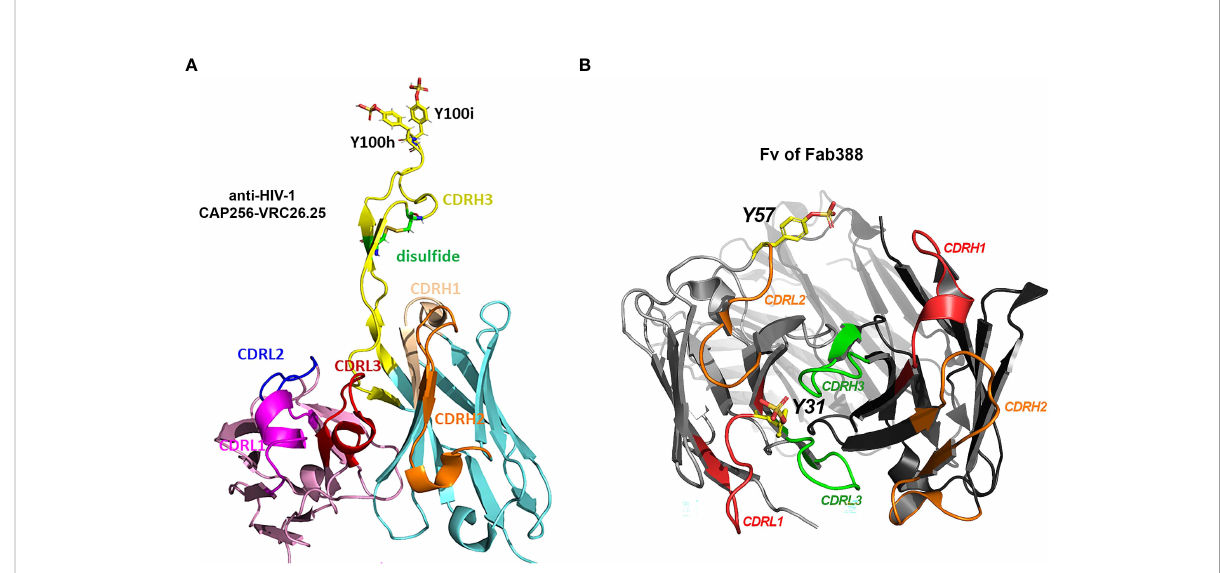
FIGURE 2 Three types of Tyr sulfation modi fi cation at antibody CDRs. (A) Structural display of sTyr residues at CDRH3 of anti-HIV-1 antibody CAP256- VRC26.25 (Gorman, Chuang et al. 2020). PDB 5DT1 (47, 81). (B) sTyr residues at CDRL1 (Y31) (40) and CDRL2 (Y57) (41) are displayed on antibody Fab structure (Fv of Fab388). Sulfated tyrosine residues were modeled on the corresponding Fab structure PDB 5I1A (14, 82) using Pymol molecular graphics